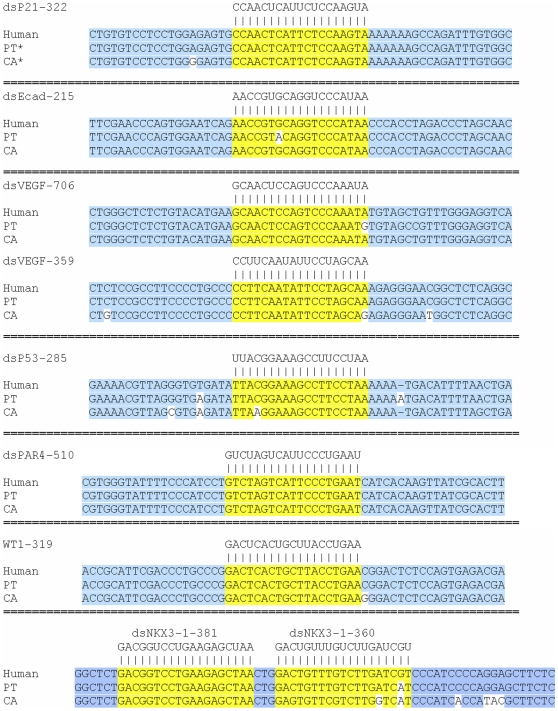
Primate saRNA sequences and target alignments.Genomic DNA was isolated from WES and COS1 cells. Gene promoter regions surrounding saRNA target sites were sequenced using promoter-specific primers. Indicated are the saRNA sequences aligned to human, Pan troglodytes (PT; chimpanzee), and Cercopithecus aethiops (CA; African green monkey) promoter sequences. Target sites are highlighted in yellow, while non-target sequence is highlighted in blue. Genomic sequences divergent from human are not highlighted. The numerical designation within the name of each saRNA denotes the target location on each gene promoter relative to the transcription start site of the human gene.